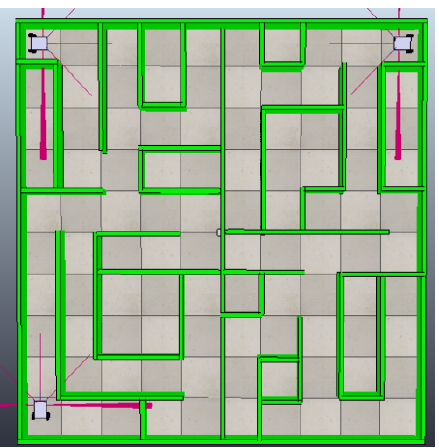
Figure 9. Experiment with three robotic agents.